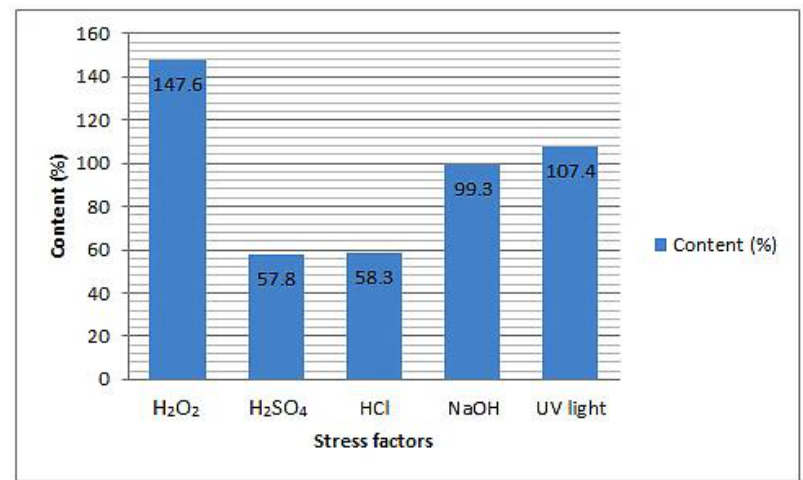
Fig. 2. Percentage content (%) of furosemide in stressed samples after assay. Rectangular bars with figures depict the mean content (n=5) of furosemide in samples subjected to stress conditions (x-axis). Values beyond 100±5 % indicate occurrence of degradation. * – P<0.05 compared with control